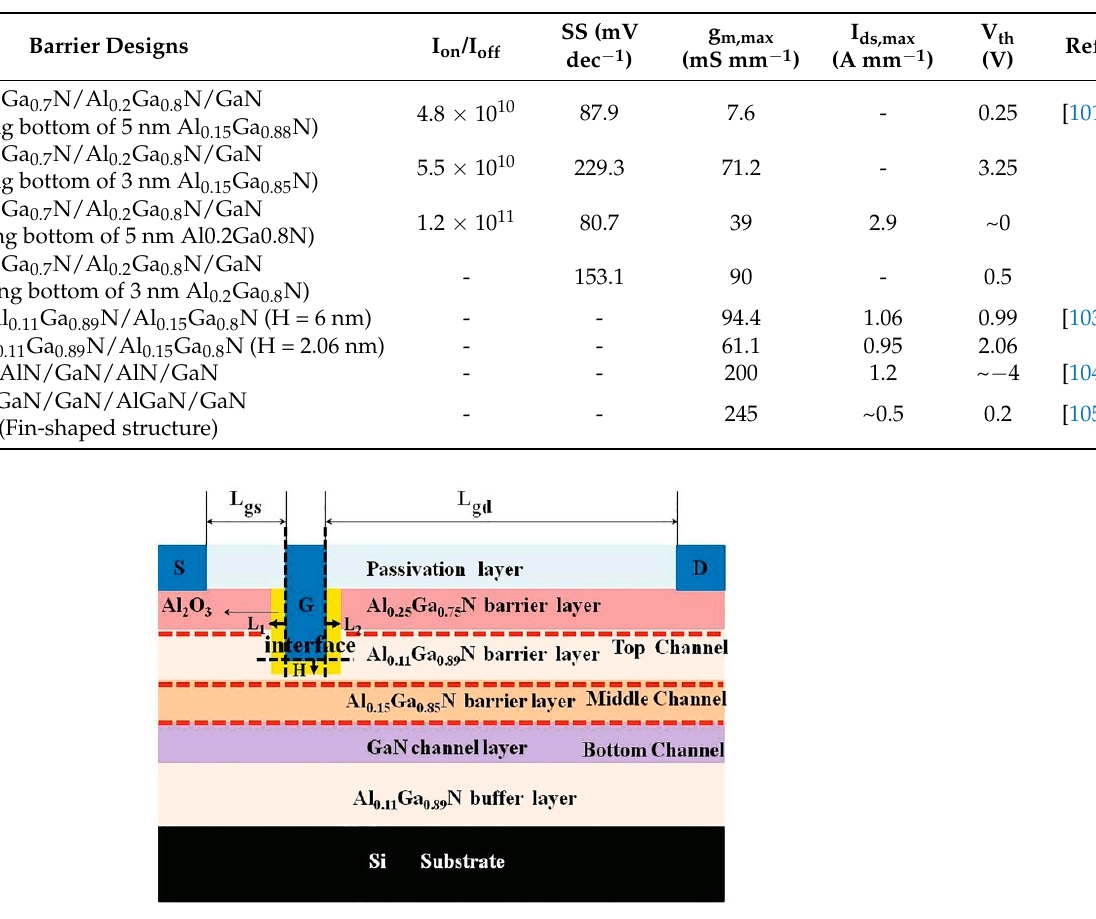
Figure 6. Schematic of an enhancement-mode HEMT with triple AlGaN barrier. Reprinted with permission from ref. [103]. Copyright 2021 Elsevier. Table 3. Electrical characteristics of multiple-barrier GaN-based HEMTs, based on recent literature. The threshold voltage (V th ) varied greatly depending on the AlGaN barrier layers’ design and re- cessed-gated depth (H).